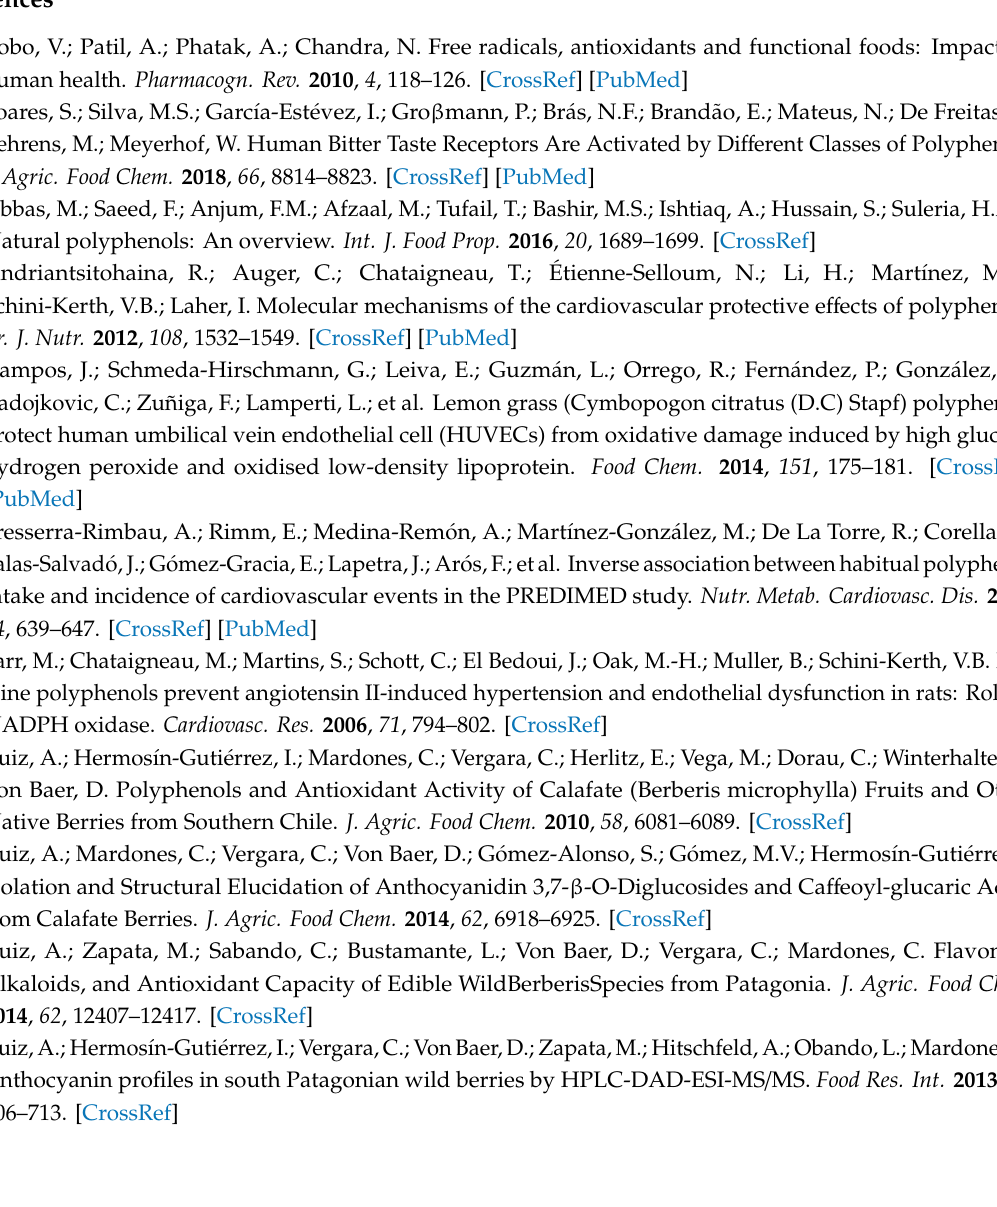
Figure S5: In vitro viability assay determined by MTT method, and Method “Determination of Fe in calafate extract by atomic absorption spectroscopy